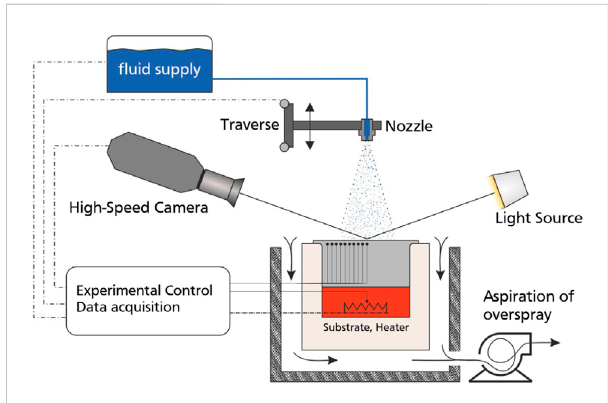
FIGURE 1 Schematic representation of the spray cooling experimental setup.